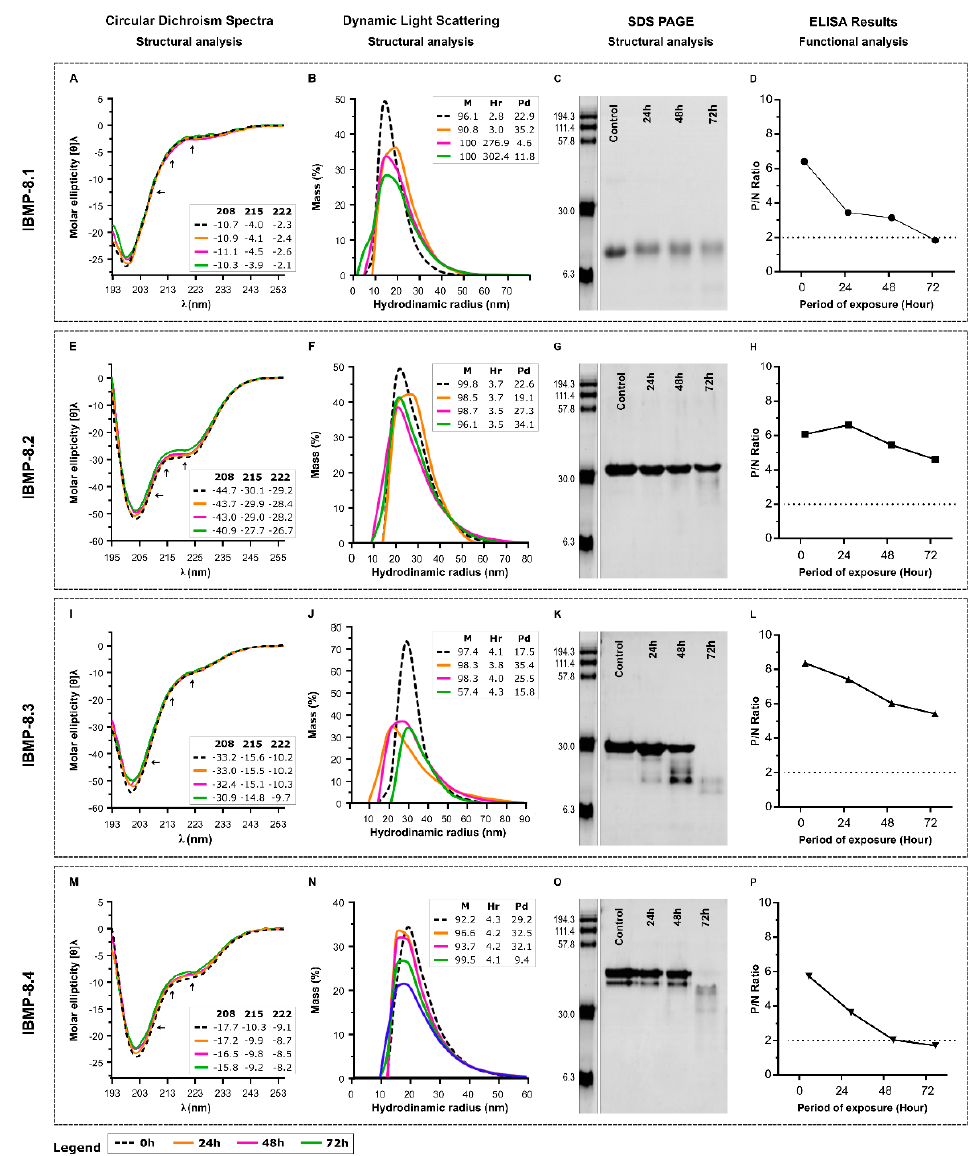
Figure 3. Evaluation of storage stability at 25 °C for IBMP recombinant chimeric proteins by CD, DLS, SDS-PAGE and sera reactivity by ELISA. DC (Circular dichroism); h (hours); Hr (hydrodynamic radius); M (%mass); nm (Nanometer); P/N ratio (Positive/negative ratio). Boxes in ( A , E , I , M ) indicate the values of CD signal intensity at 208, 215 and 222 nm. Boxes in ( B , F , J , N ) indicate the values of %mass, hydrodynamic radius and polydispersity. ( C , G , K , O ) are the SDS-PAGE images in the times described. ( D , H , L , P ) represent the reactivity of the antigens in ELISA assay after exposure time.